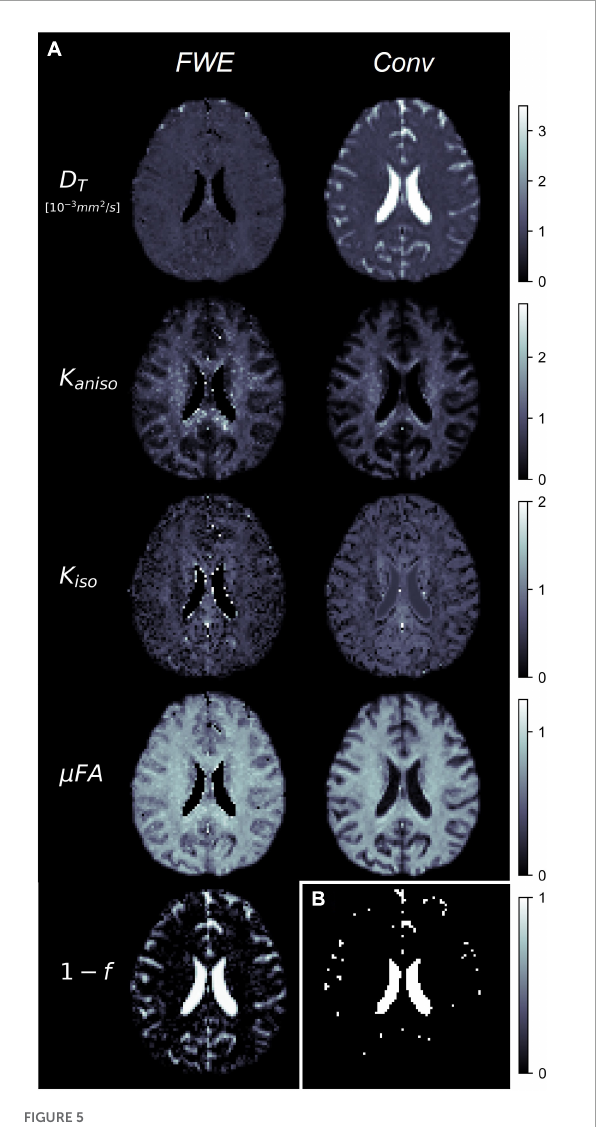
FIGURE5 (A) Example slices of tissue diffusivity ( D T ), anisotropic kurtosis ( K aniso ), isotropic kurtosis ( K iso ), microscopic fractional anisotropy ( µ FA), and fluid volume fraction (1- f ) measured in one of the healthy volunteers. The images on the left were computed using the free water elimination (FWE) method while those on the right were computed using the conventional (Conv) method. Note that D T is used interchangeably with D for the conventional method. (B) Sample slice depicting a binary map showing voxels with tissue volume fractions less than 0.25, which were omitted in region-of-interest analyses.